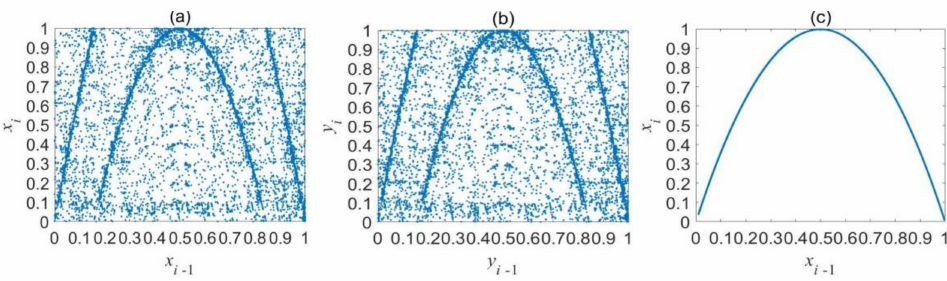
Figure 3. The phase diagrams: ( a ) x -dimensional variable of improved sequences ( b ) y -dimensional variable of improved sequences ( c ) Equations